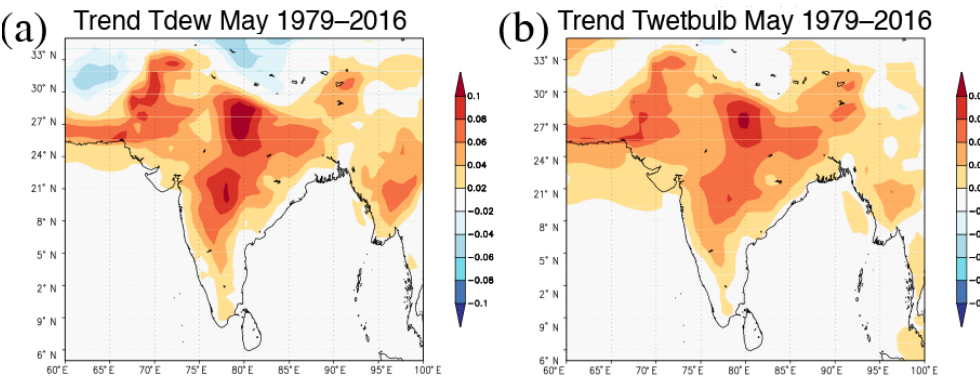
Figure 8. Trend in (a) dew point temperature, (b) wet bulb temperature in ERA-Interim over May (Kyr − 1